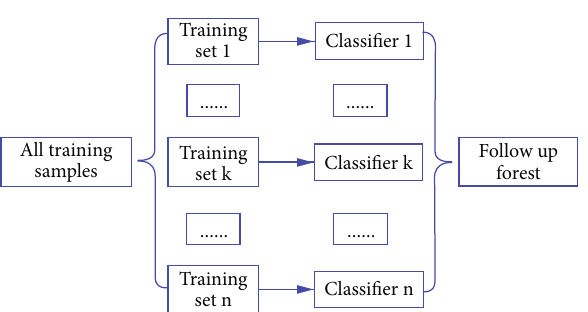
Figure 2: Random forest classi fi cation